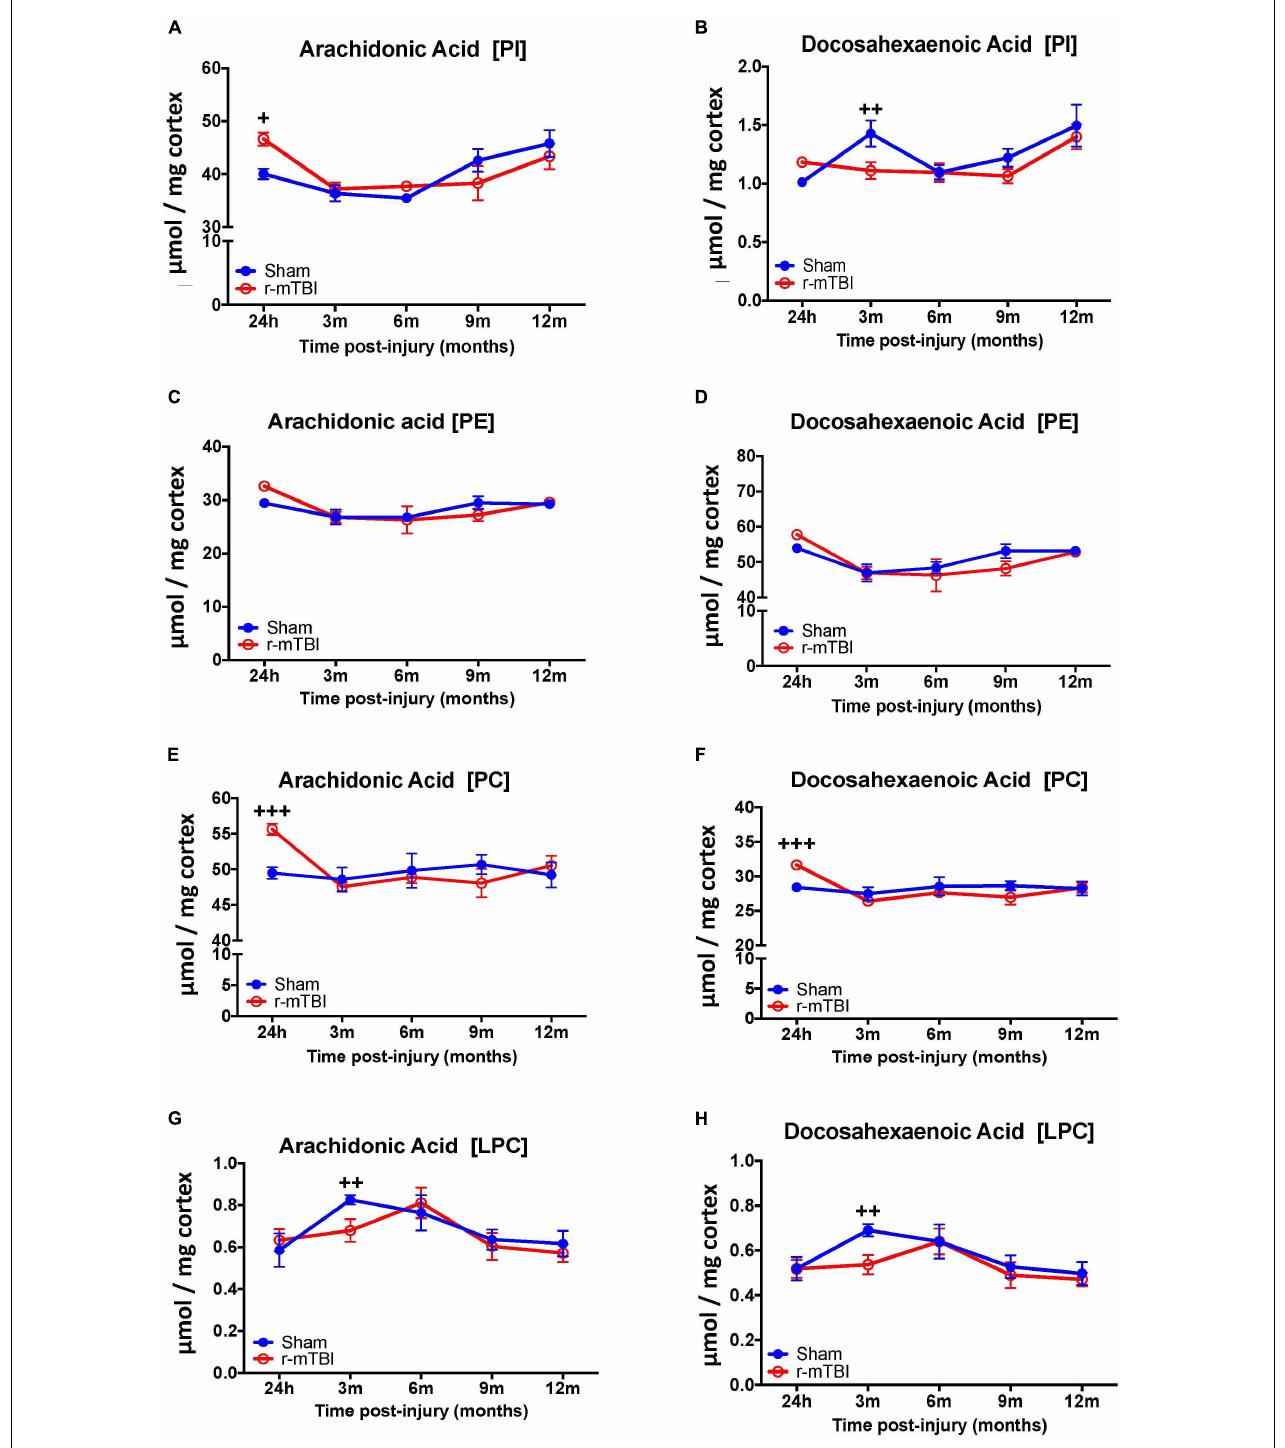
FIGURE 5 | Arachidonic acid and docosahexaenoic acid containing phospholipid species in the cortex of repetitive mTBI hTau mice. Significant changes in arachidonic acid and docosahexaenoic acid containing PI (A,B) , PE (C,D) , PC (E,F) , and LPC (G,H) species in the cortex of a model of repetitive-mTBI in hTau mice. Sample size for all groups across all time points is n = 4. Data represents mean µ mol per wet weight (10 mg) ± SEM. Individual molecular lipid species were quantified by liquid chromatography/mass spectrometry and were summed after LipidomeDB analyses to generate arachidonic and docosahexaenoic acid levels for each phospholipid species. Asterisks represent + P < 0.05, ++ P < 0.01, +++ P < 0.001 for comparisons between sham/r-mTBI mice. PE, phosphatidylethanolamine; PC, phosphatidylcholine; PI, phosphatidylinositol.